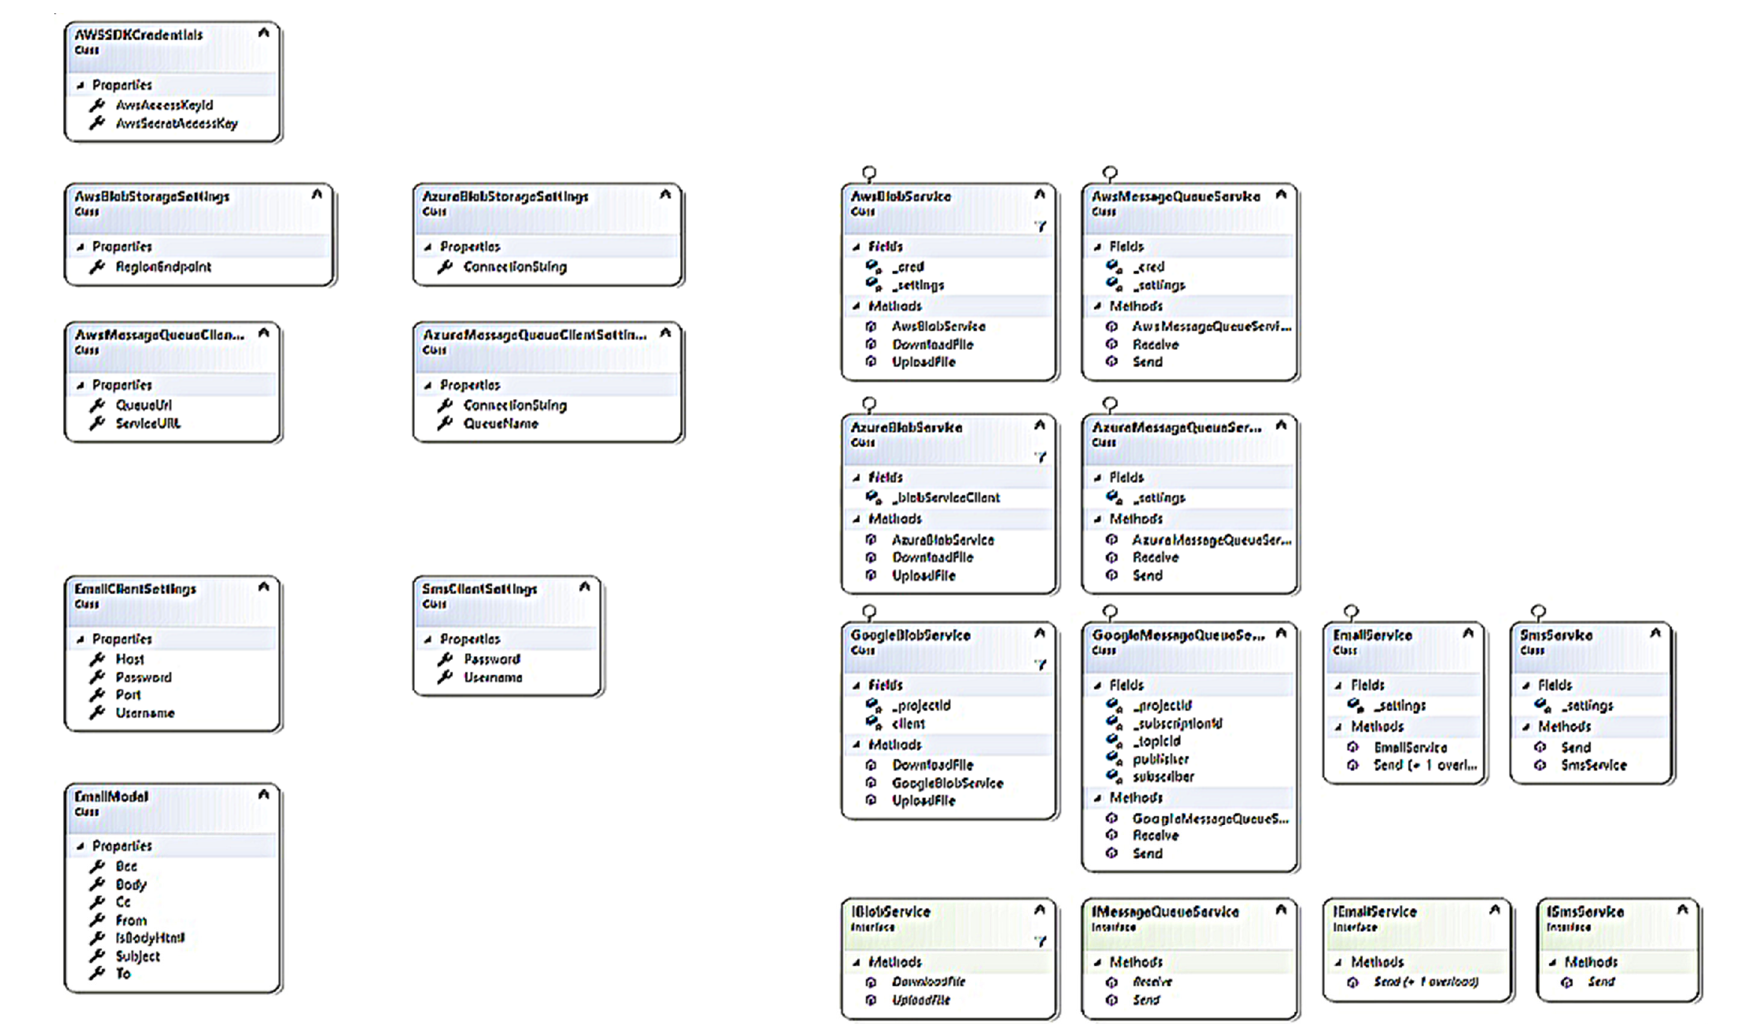
Figure 2. Class diagram for proposed methodology.